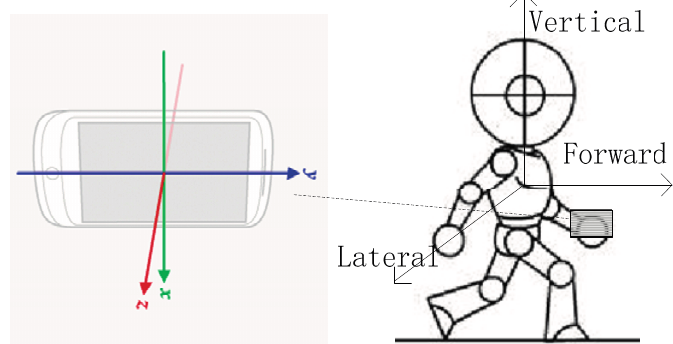
Figure 8. Schematic of coordinate axes.